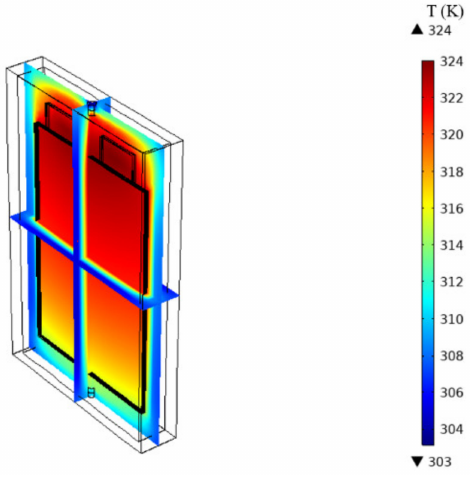
Figure 6. Temperature non-uniformity under natural